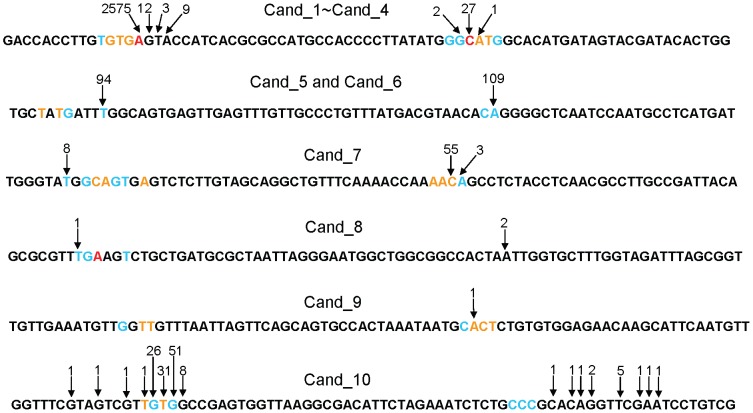
Comparison of 5′-ends of mature miRNAs predicted by miRRim2 and those identified by deep-sequencing. The probability of a predicted 5′-end (P5end
i) is indicated by colours; Black, blue, orange, and red means 0≤P5end<0.05, 0.05≤P5end<0.1, 0.1≤P5end<0.4, and 0.4≤P5end, respectively. Arrows indicate the 5′-ends identified by deep-sequencing experiments by Hendrix et al. The number associated with an arrow indicates the number of reads.